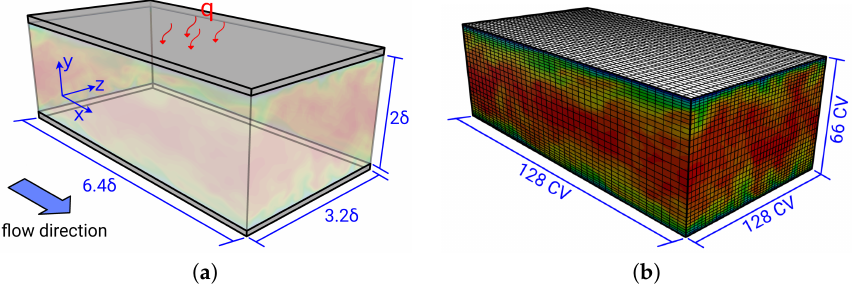
Figure A1. Flow domain ( a ) and numerical grid ( b ) of the fully-developed heated channel flow simulation. CV : control volumes. The coordinate system is given as x , y , z .